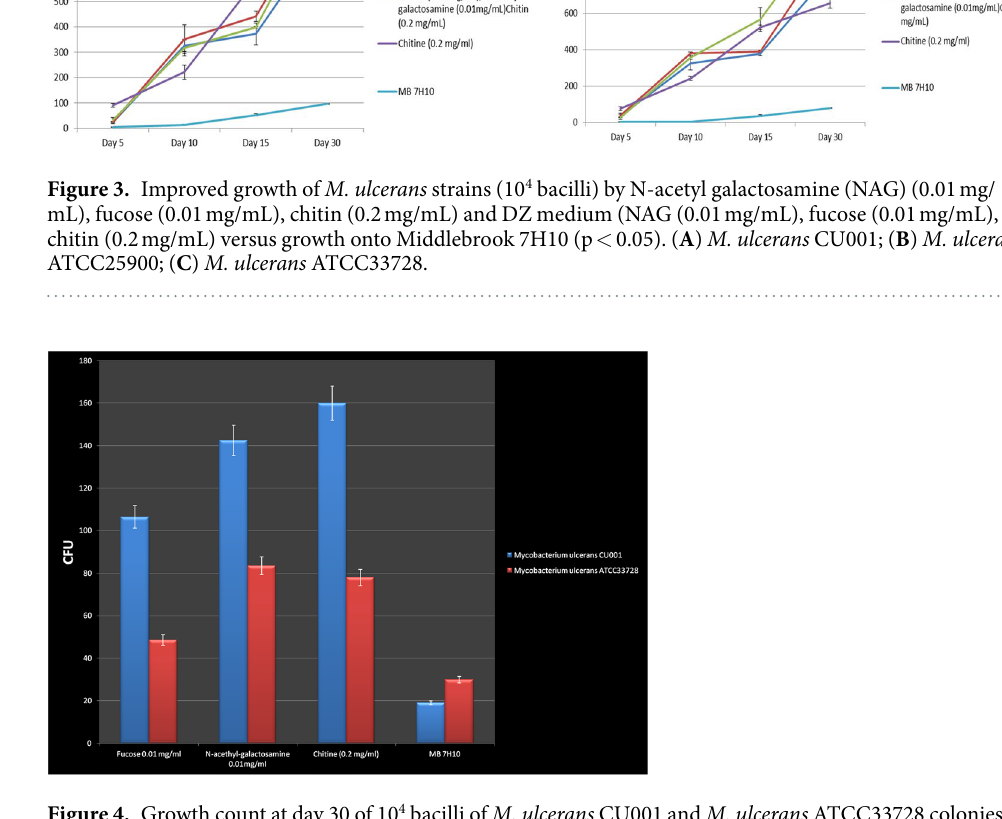
Figure 4. Growth count at day 30 of 10 4 bacilli of M. ulcerans CU001 and M. ulcerans ATCC33728 colonies after 1% chlorhexidine decontamination of river freshwater artificially inoculated with M. ulcerans strains and cultured onto growth promoters and Middlebrook 7H10. Blue column: Mycobacterium ulcerans CU001; Red column: Mycobacterium ulcerans